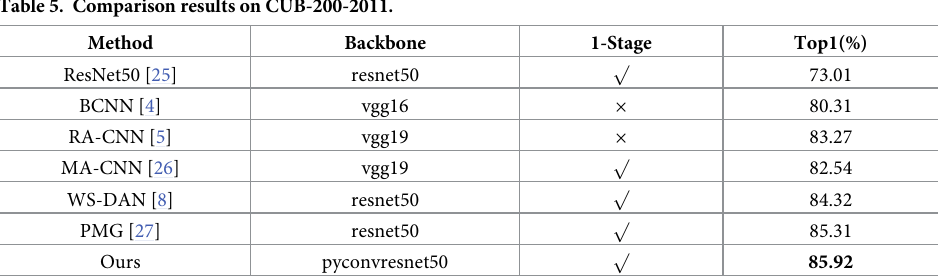
Table 5. Comparison results on CUB-200-2011.